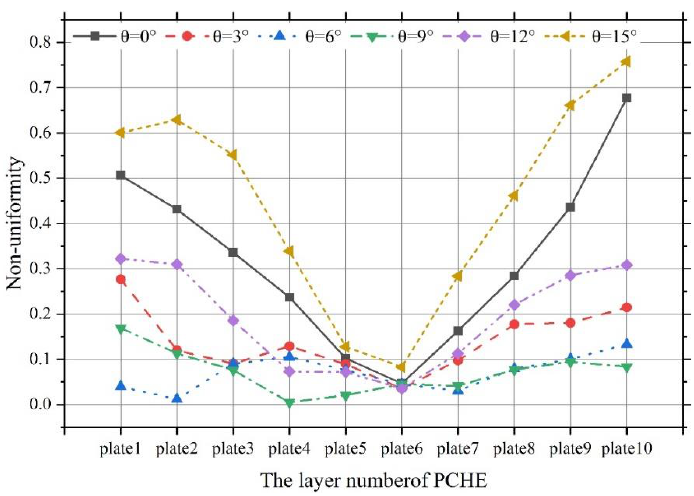
Figure 10. Non-uniformity of each layer.